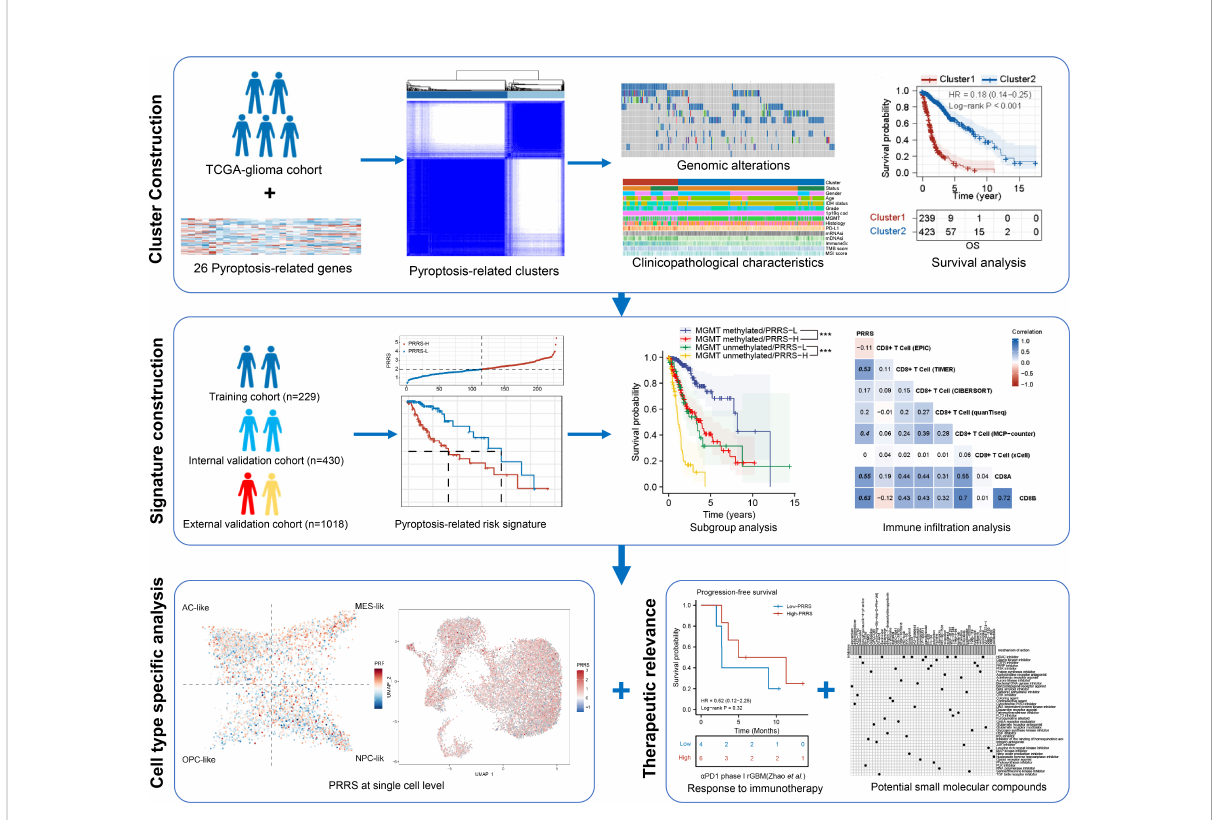
FIGURE 1 Schematic diagram of working fl